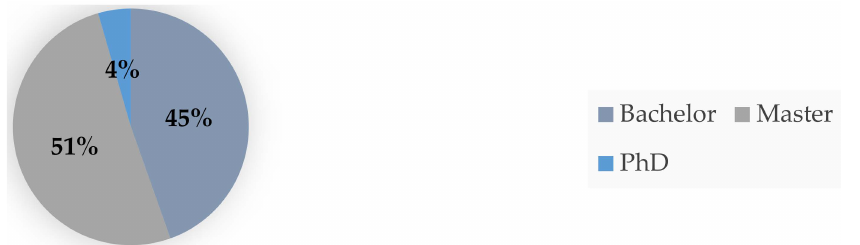
Figure 18. Percentage of DCH Bachelor’s, Master’s, and doctoral programs in Europe (n = 267, investigated in